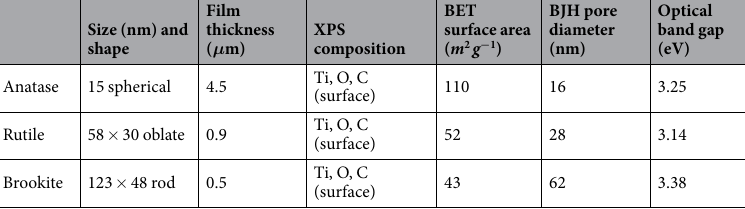
Table 1. Summary of the results of physical characterization of mesoporous anatase, brookite and rutile.